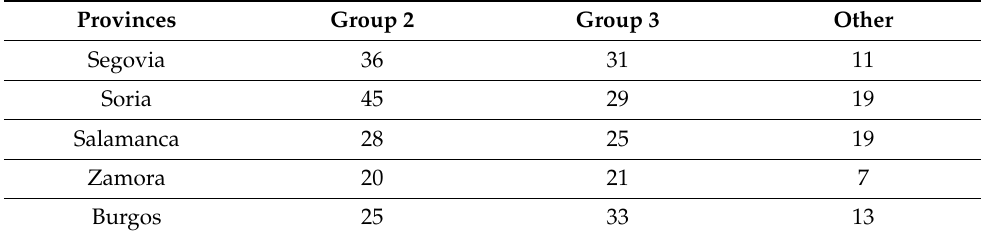
Table 2. Classification of the farms under